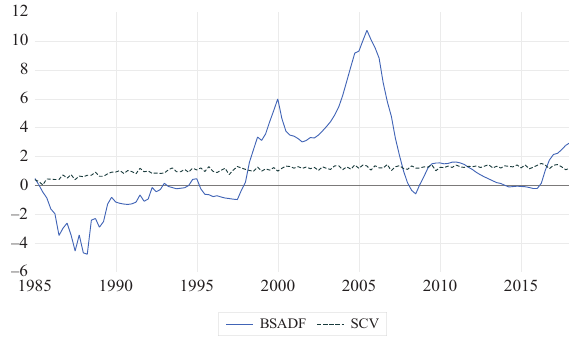
Figure 3. The statistics of the BSADF (the overall housing market)